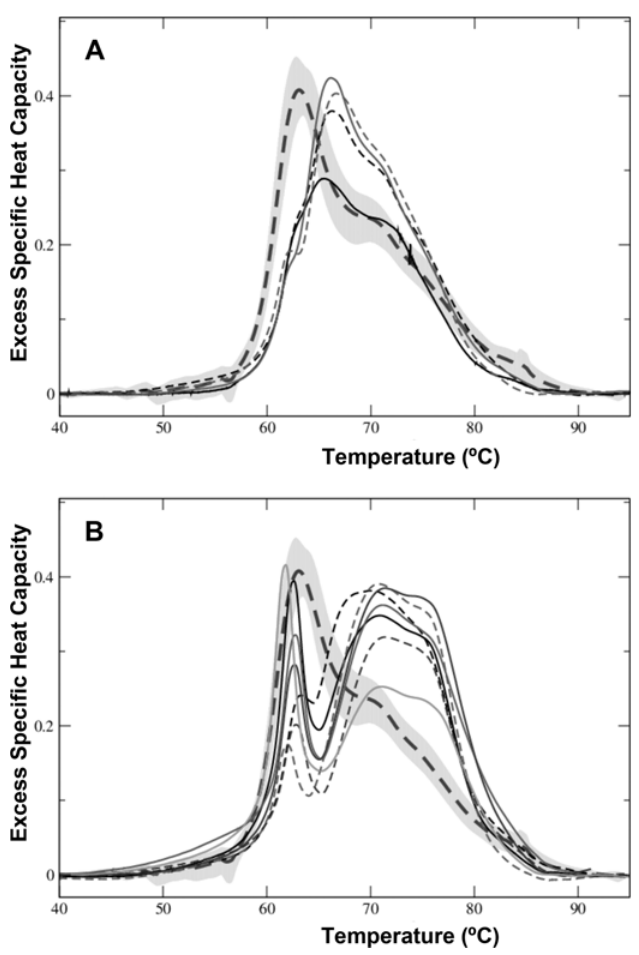
Fig 4. DSC thermograms of serum samples from non-MGUS individuals. Non-MGUS refers to serum samples from individuals with subjacent immunological pathologies who were ruled out of having MGUS through serum immunofixation. (A), (B) Two sets of themograms obtained from non-MGUS individuals. For the ease of visualization, the experimental thermograms were clustered in either panel based on the similarity of the shapes of their DSC profiles. For the sake of comparison, the average healthy (control) thermogram is presented in all the